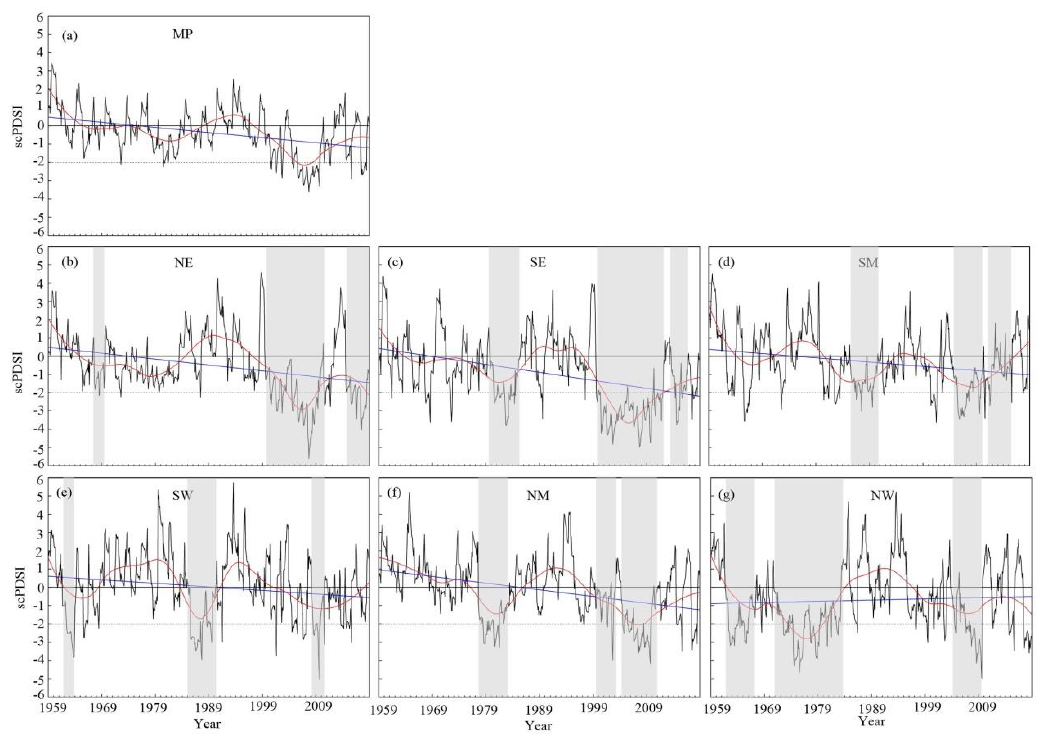
Figure 6. Evolution of the average scPDSI in the MP and the six sub-regions. The blue line represents the linear trend. The red line indicates the LOESS lines with a time span of 20 y. The gray areas represent the three drought events with the longest duration in the different sub-regions. ( a ) MP, ( b ) NE, ( c ) SE, ( d ) SM, ( e ) SW, ( f ) NM, ( g ) NW.